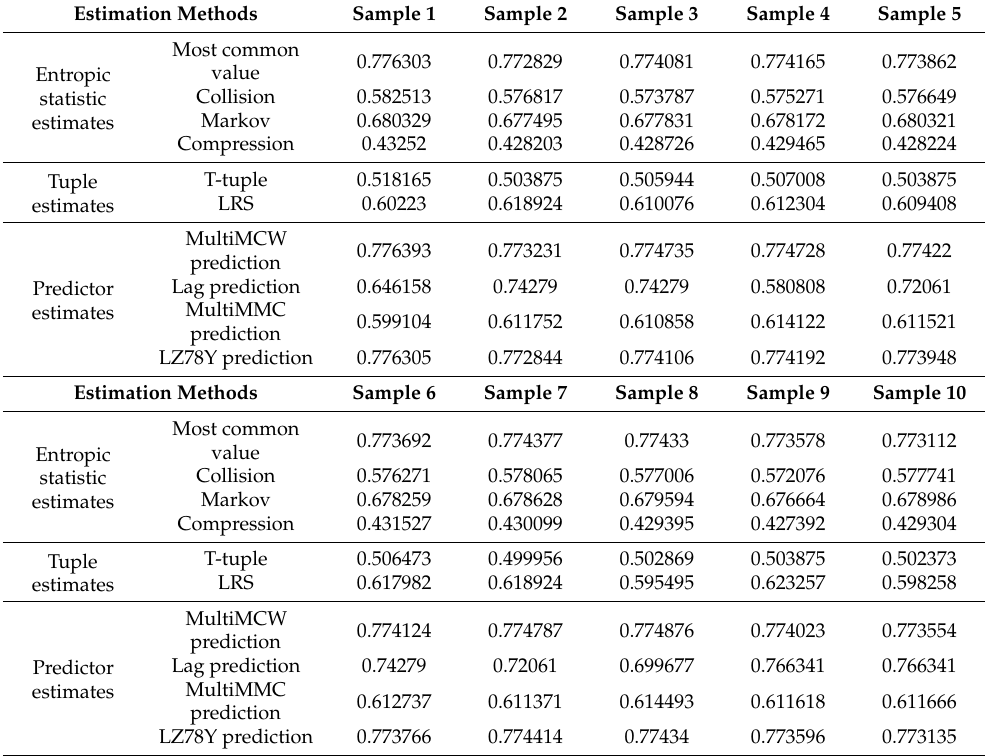
Table 4. Entropy rate of the raw true random bits.